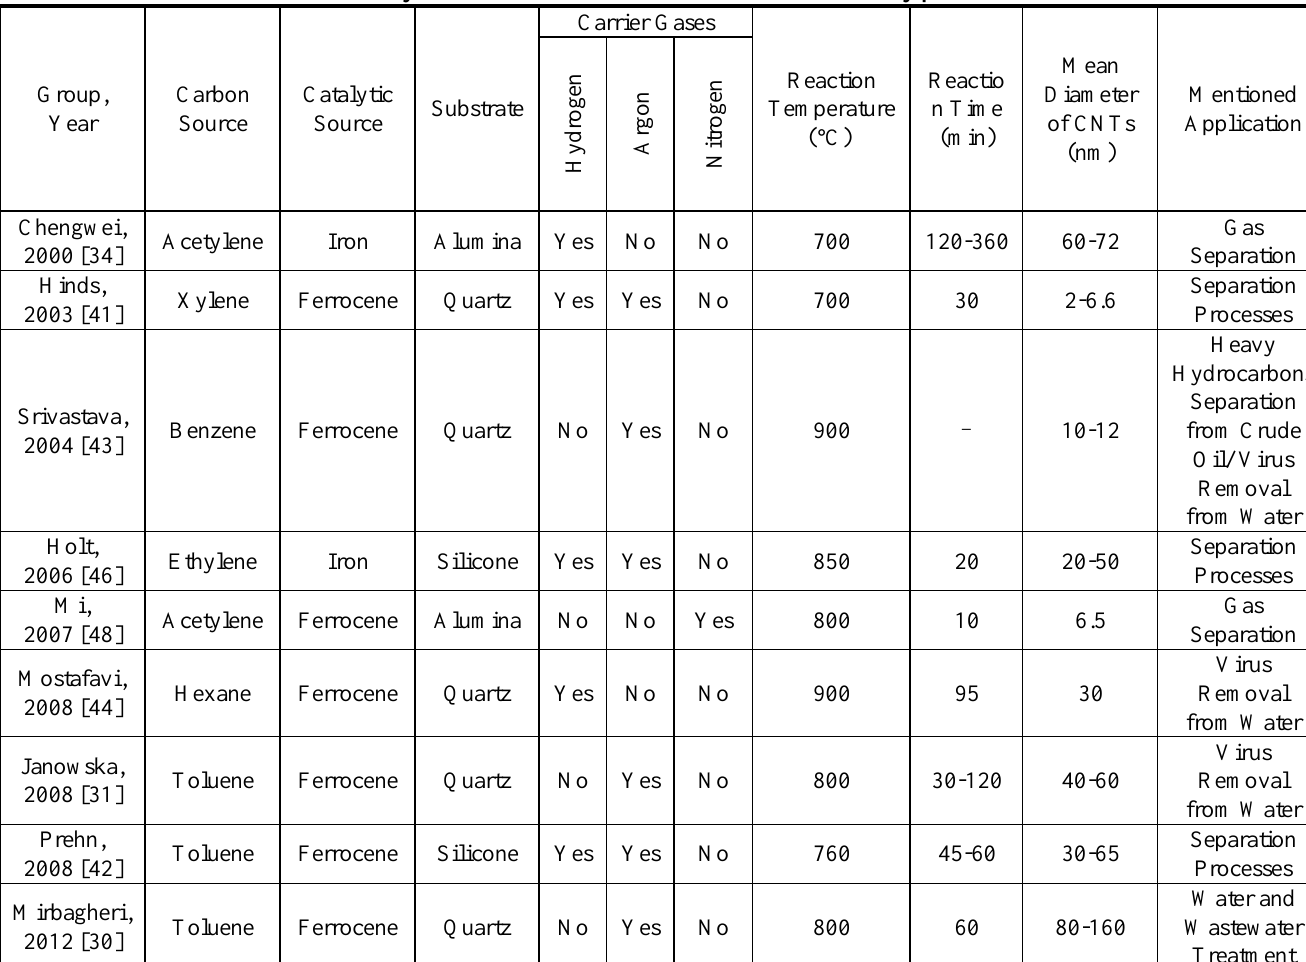
Table 2. Summary of CNT membranes information fabricated by pervious